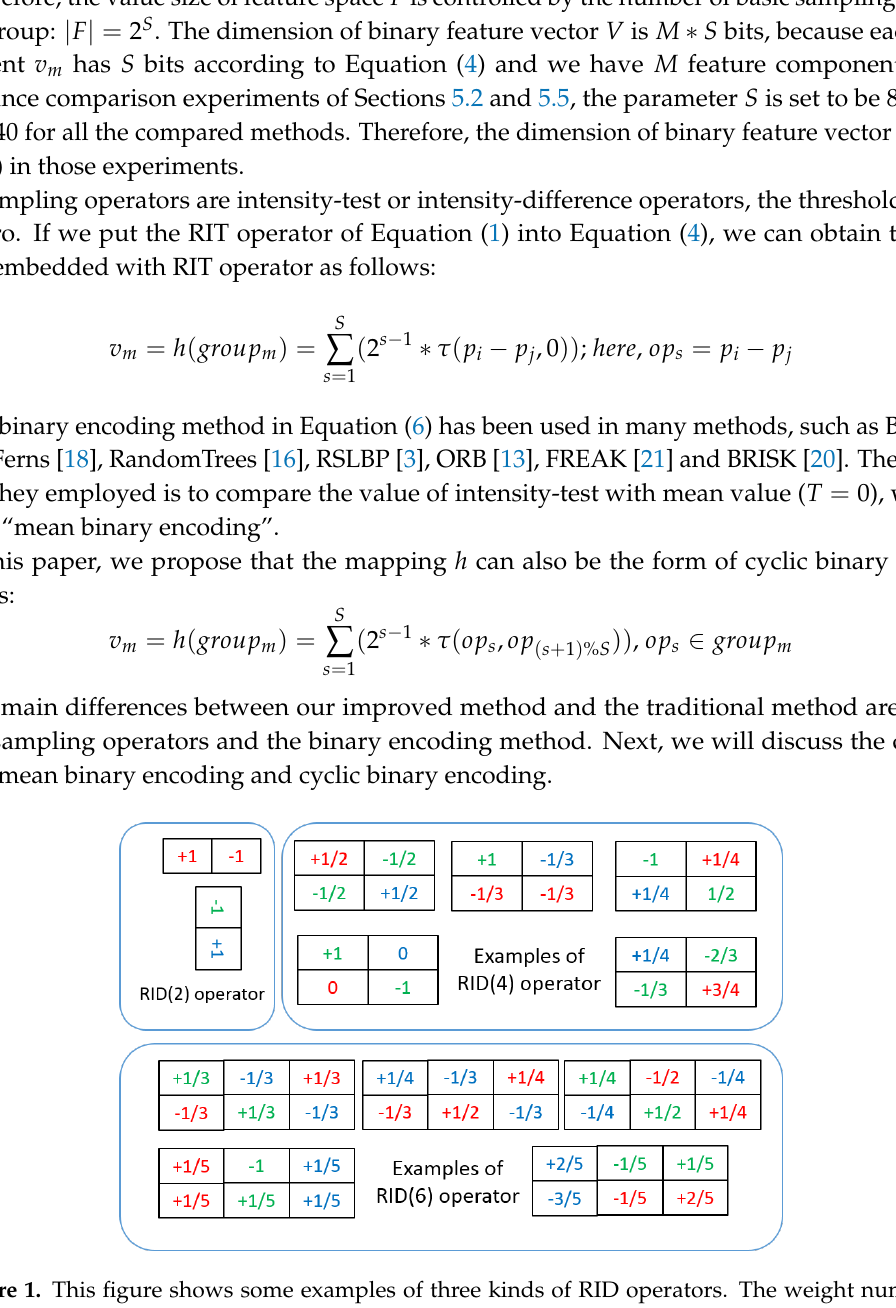
Figure 1. This figure shows some examples of three kinds of RID operators. The weight numbers of sampling cells within each operator are pre-selected randomly according to Equation (3) when generating operators. However, the weights of RID(2) operator have no randomness when image rotation occurring. The color of weight number of each cell is used to represent the sampling channel of that cell. Each operator can put its several cells into different channels so as to implement multi-channel joint randomized binary coding. These randomized sampling operators are pre-generated before applying them on image patches of all keypoints. Once generated, they will stay the same for all